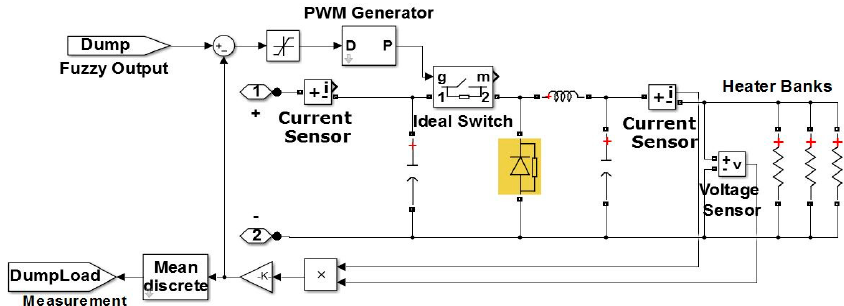
Figure 6 . Internal configuration of the dump load controller. Figure 6. Internal configuration of the dump load